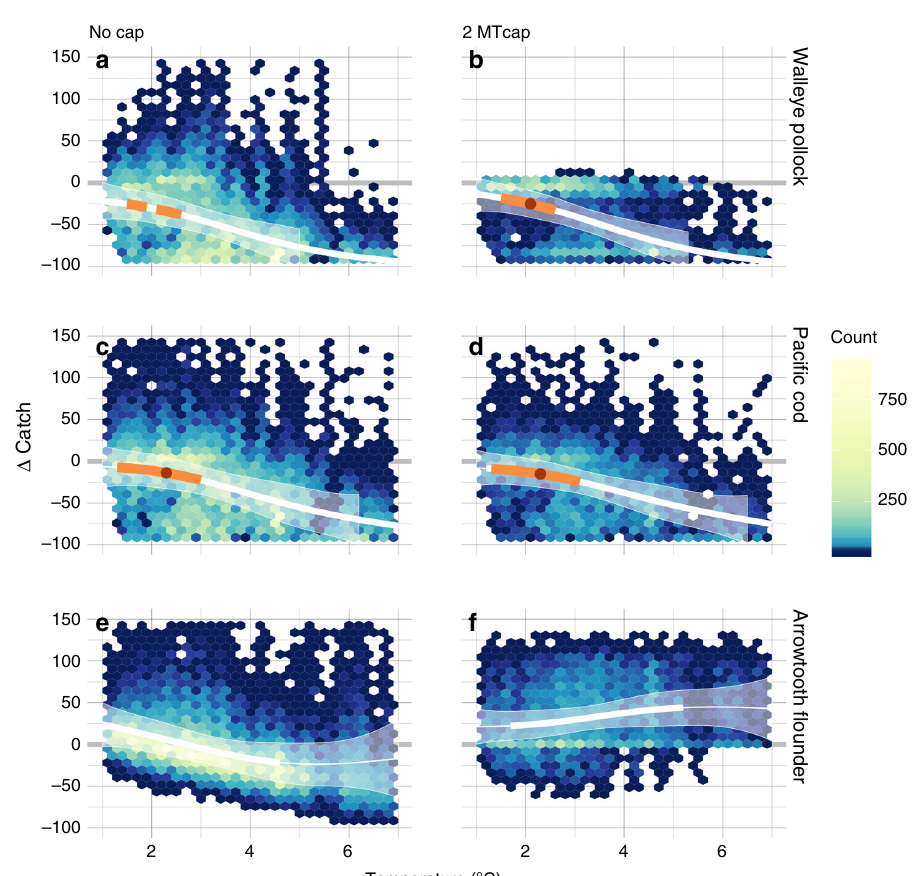
Fig. 6 Thermal tipping points for catch and biomass. Analysis of proportional change in future catch relative to the persistence scenario ( Δ Catch) as a function of future bottom temperature (°C). Solid lines represent the mean smoothing function (s(x)); shading indicates the 2.5 and 97.5% quantiles from 1000 bootstrap replicates. Scenarios without the 2 MT cap ( a , c , e ); scenarios with the 2 MT cap ( b , d , f ). Rows correspond to each species. The thick white and orange lines indicate areas where the 95% CI of the fi rst derivative (s(x) ′ ) of the smoothing functions do not include zero; orange bar indicates indicate where the 95% CI of the second derivative (s(x) ″ ) does not overlap zero; on each line, red circles indicate the best estimate of the tipping point (i.e., s(x) ″ is most different from